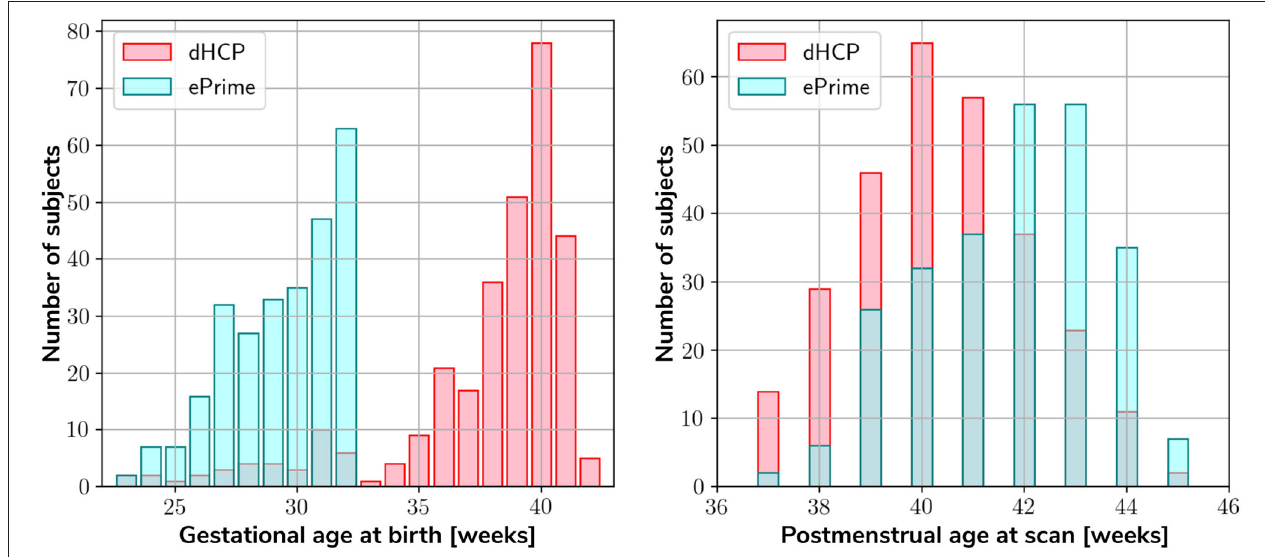
FIGURE 1 | Age distribution of the subjects in our datasets, showing both their GA at birth, as well as their PMA at scan.